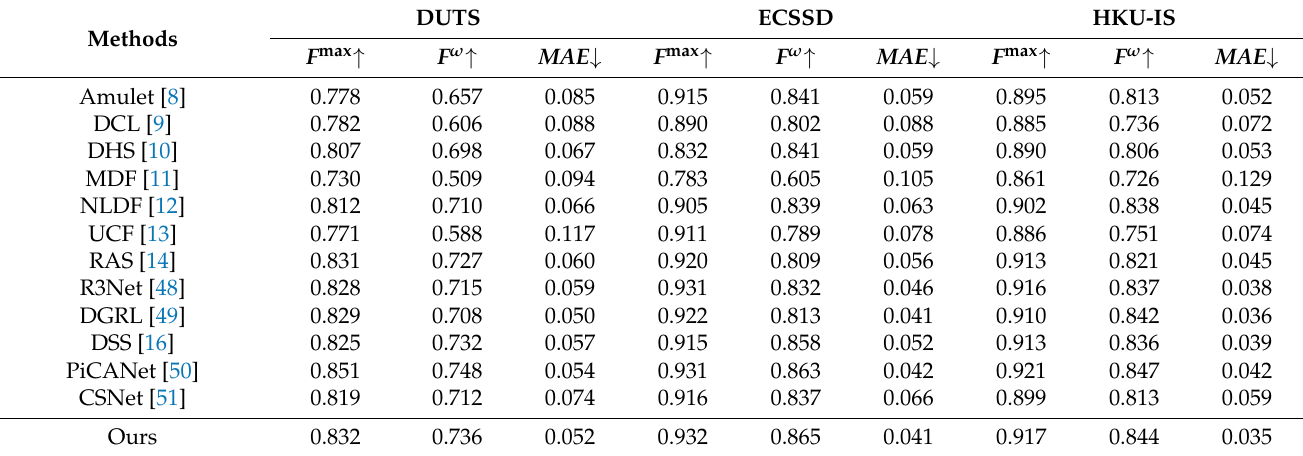
Table 2. Comparison of the F -measure evaluation metric and MAE score on different